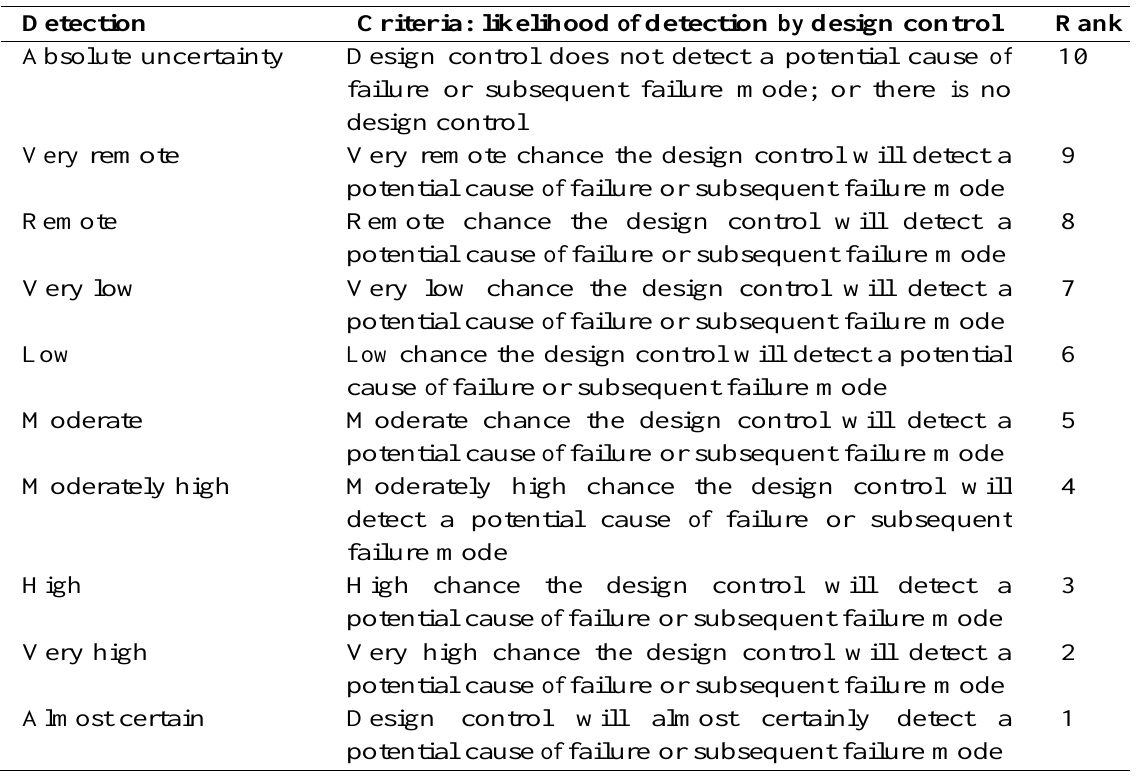
Table 3. Crisp rating for detectability of a failure